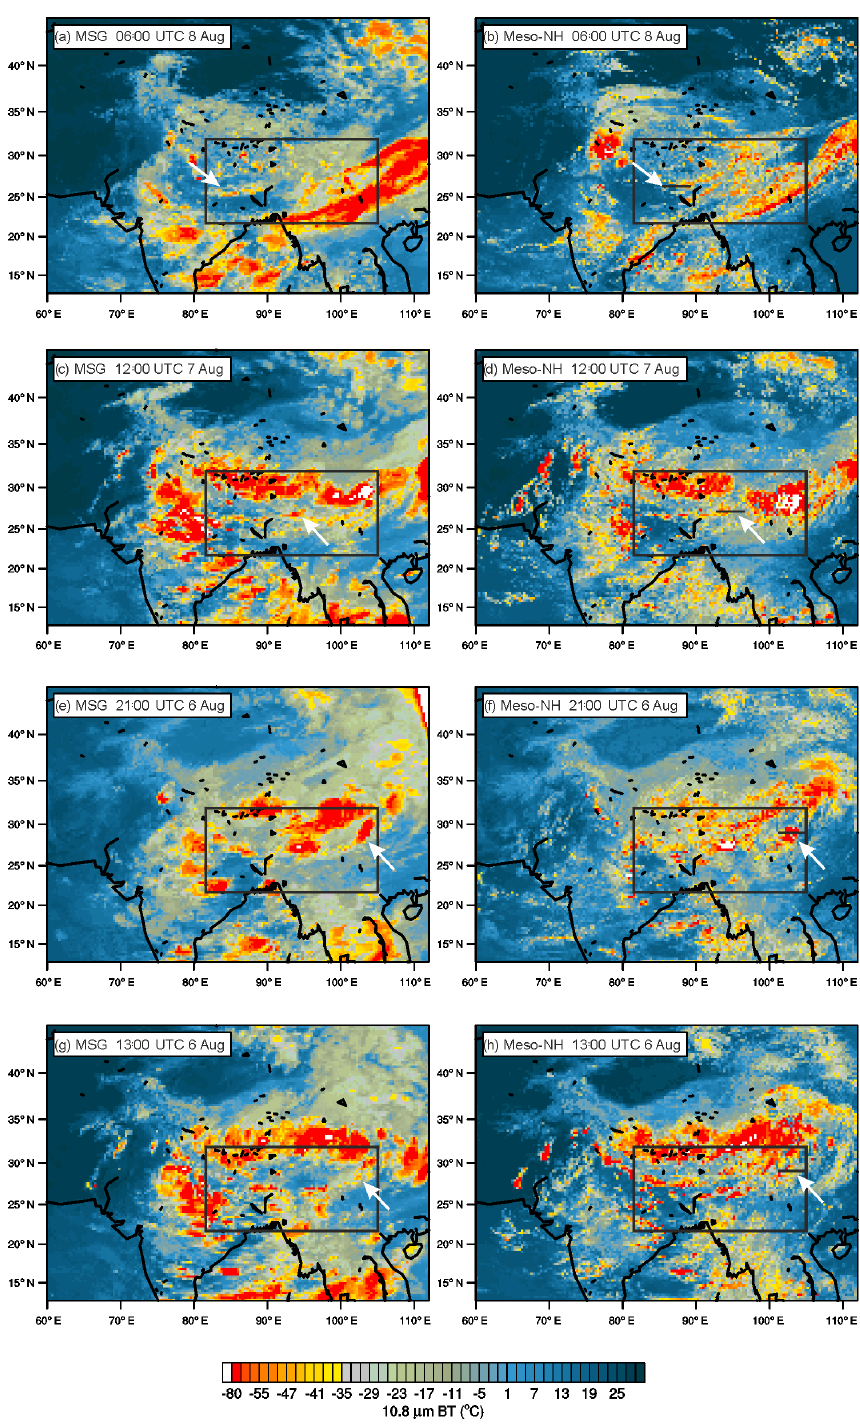
Figure 5. BT at 10.8µm obtained from MSG–SEVIRI (left) and Meso-NH (right) at (a, b) 06:00UTC on 8 August, (c, d) 12:00UTC on 7 August, (e, f) 21:00UTC, and (g, h) 13:00UTC on 6 August 2017. The domain used in Fig. 4 is marked by a box in each panel, while the location of vertical cross sections used in Figs. 6–9 is marked by a black solid line in the right panels. The location of the hydration patch is depicted by the white